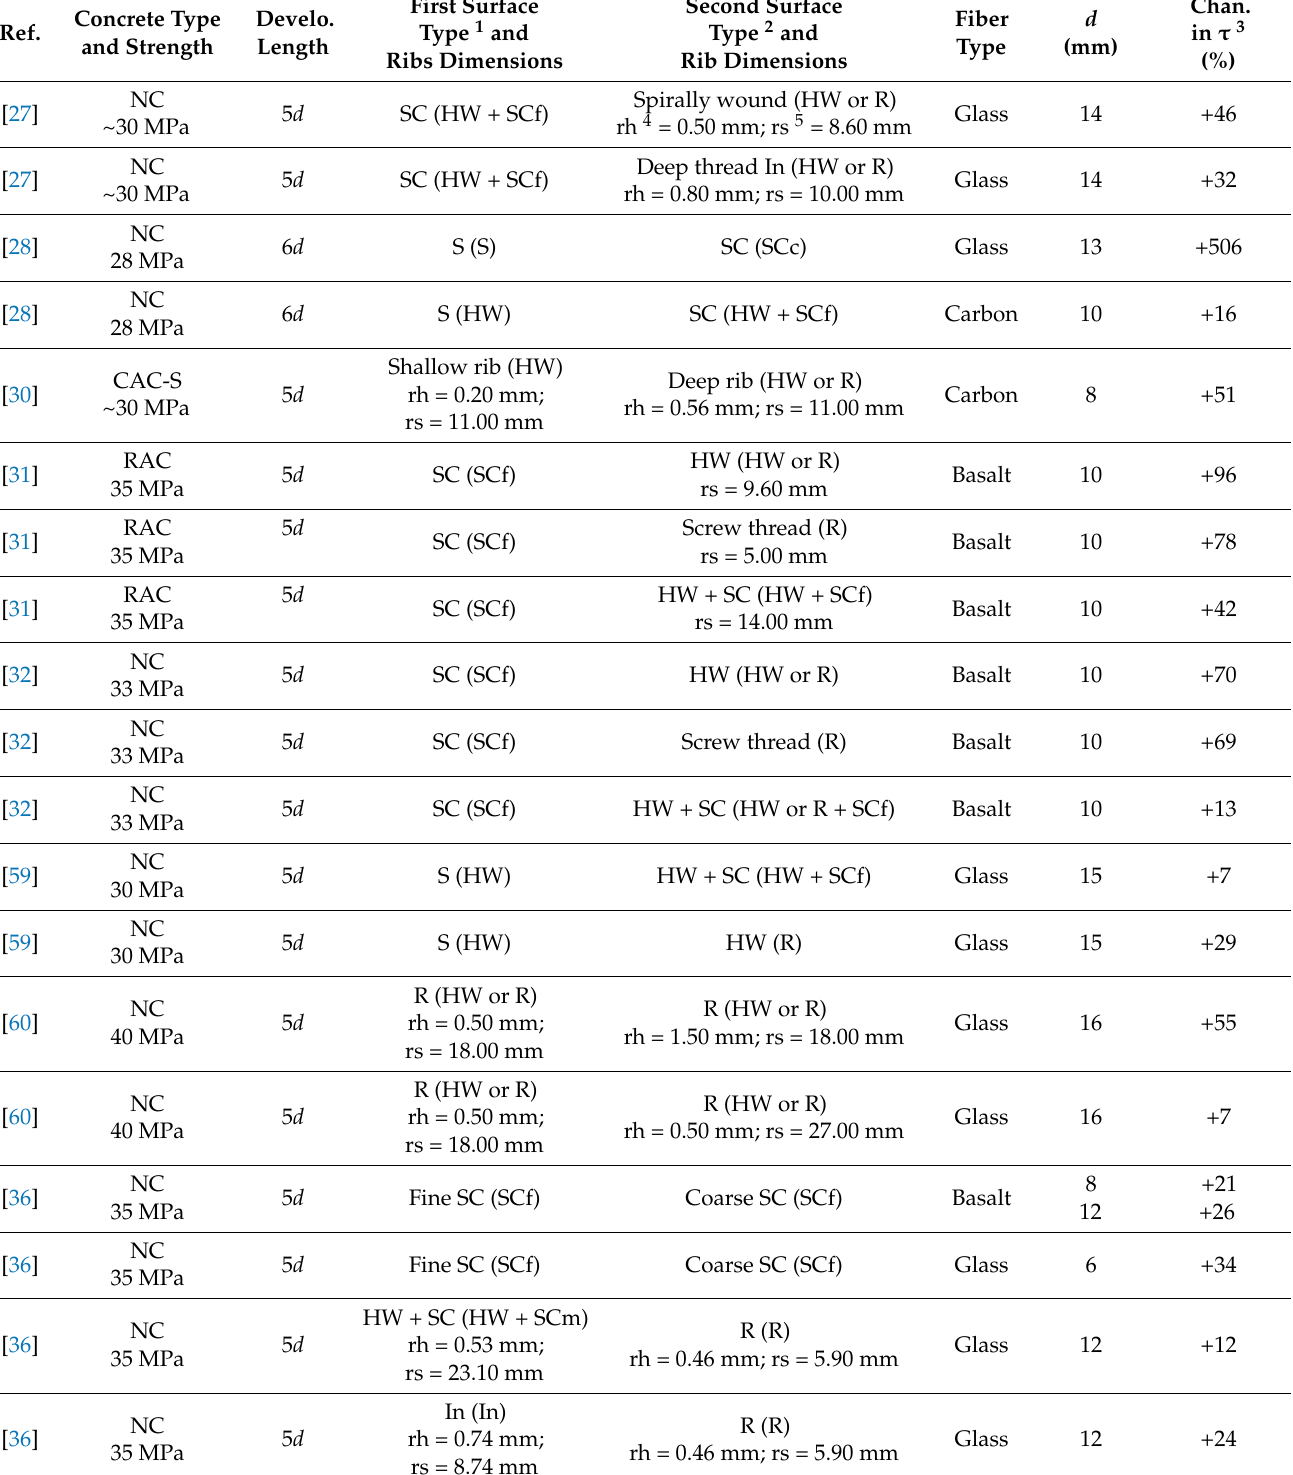
Table 3. Studies on the influence of surface type on FRP–concrete bond